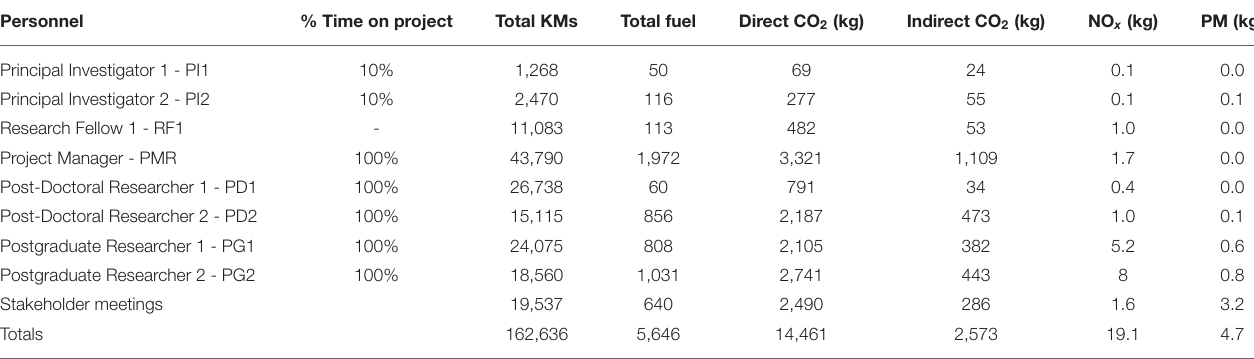
TABLE 2 | The inventory for the